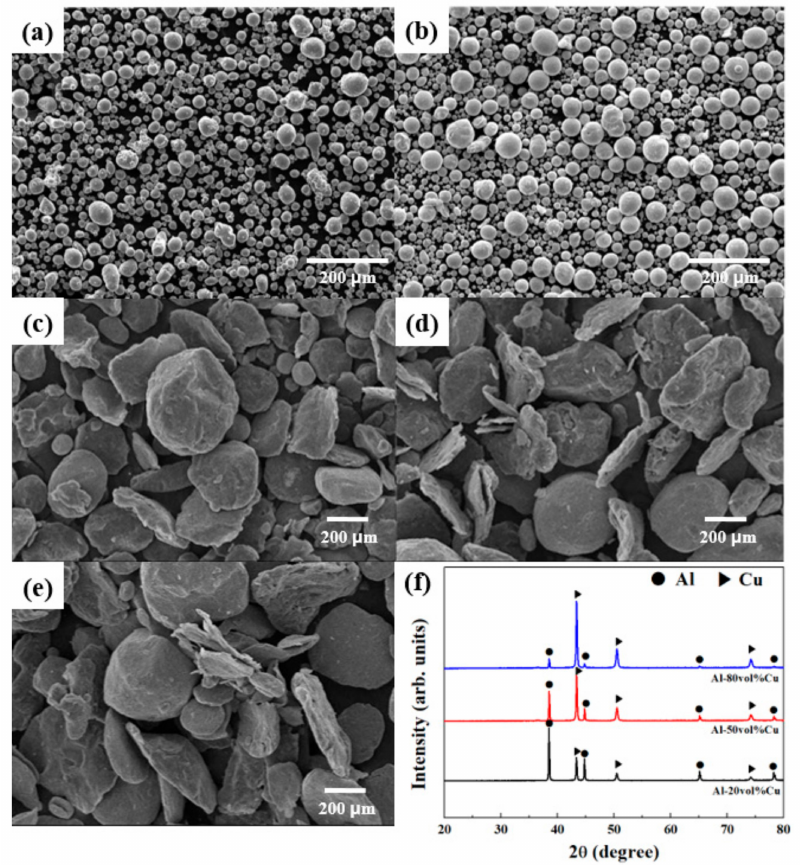
Figure 1. Scanning electron microscopy (SEM) images of ( a ) pure Al, ( b ) pure Cu, ( c ) Al–20Cu, ( d ) Al–50Cu, and ( e ) Al–80Cu powders, and ( f ) X-ray di ff raction (XRD) patterns of the composite